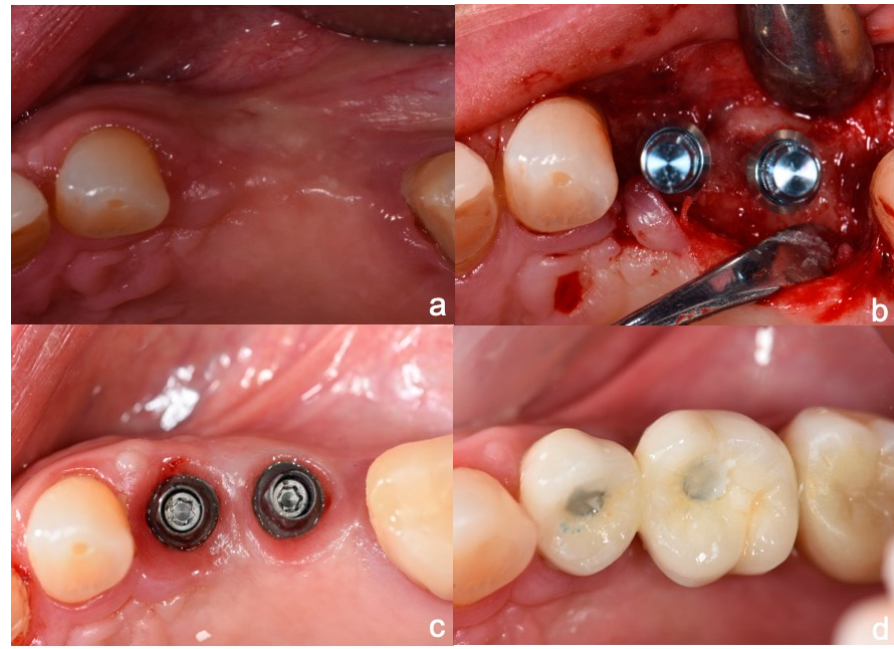
Figure 6. ( a ) Clinical spam of missing teeth; ( b ) long and extra-short implants in place; ( c ) variobase abutments screwed to the implants; ( d ) ceramic crowns in place.